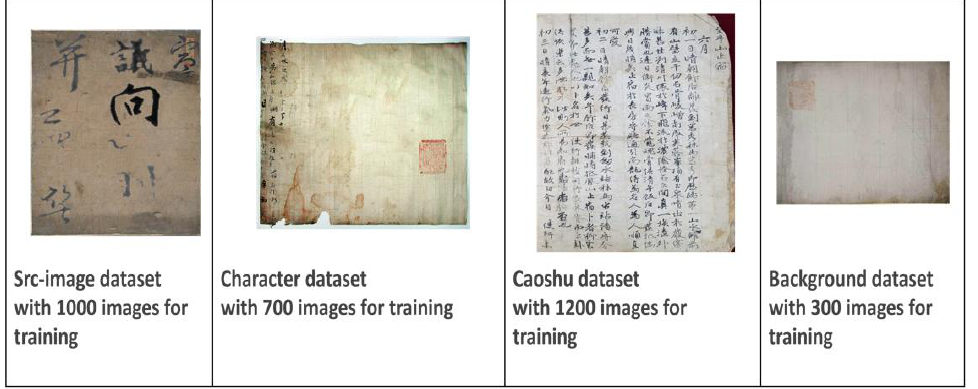
Figure 4. Samples of the four benchmark sub-sets. From left to right, the Src-image dataset, the Character dataset, the Caoshu dataset, and the Background dataset note the number of images used from each of them for training.